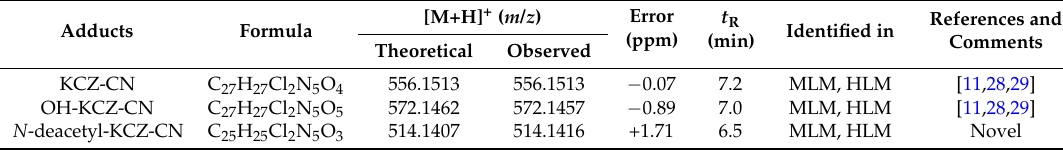
MLM: mouse liver microsomes; HLM: human liver